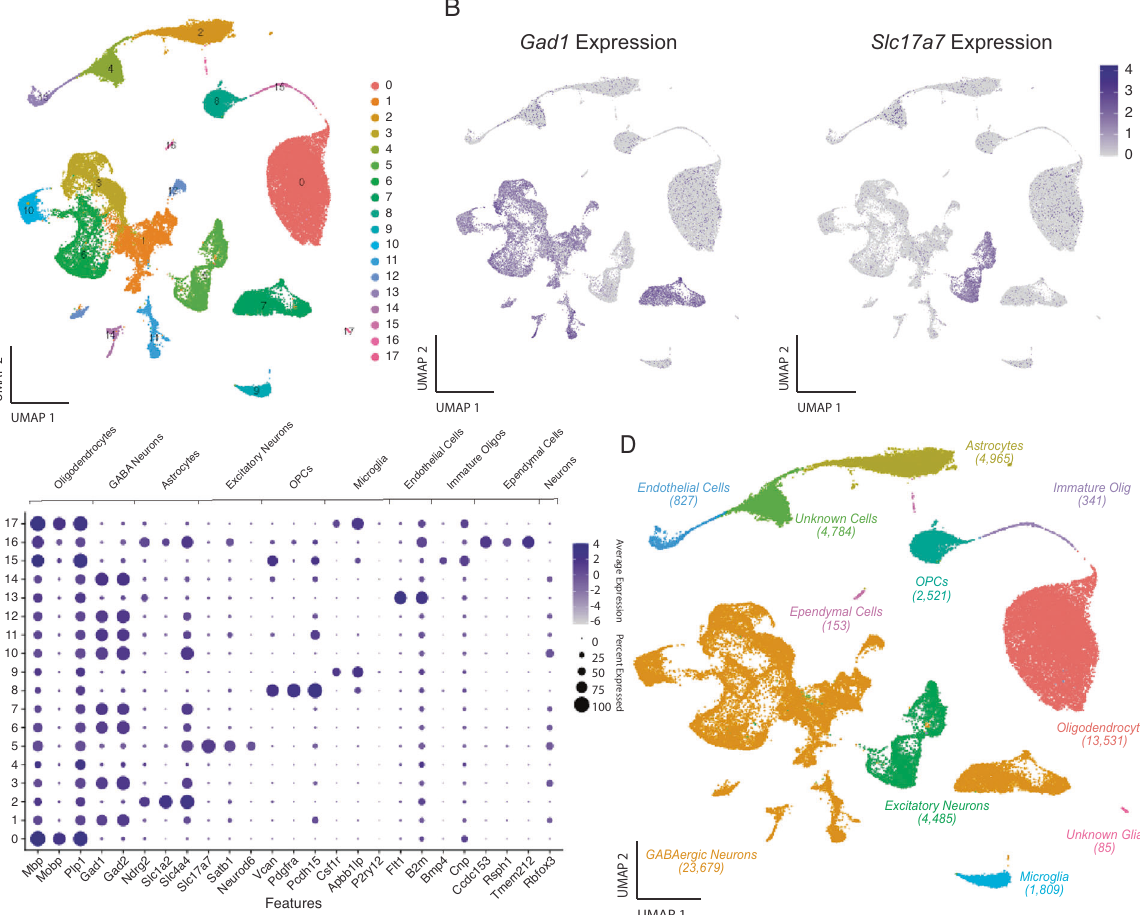
Fig. 1 Identi fi cation of major cell types within the CeA. A UMAP plot of 58,640 CeA single-nuclei colored by cluster. Louvain clustering analysis (resolution = 0.1) identi fi ed 18 transcriptionally de fi ned clusters. B UMAP plots showing the expression levels of select neuronal marker genes. Distinct populations of cells express Gad1 , a marker of GABAergic inhibitory neurons, and Slc17a7 (VGlut2), a marker of glutamatergic excitatory neurons. These data illustrate that one cluster is composed of primarily excitatory neurons, while multiple clusters are identi fi ed which represent distinct inhibitory cell classes of the CeA. C Major cell-type marker gene expression in CeA clusters. The identity of each cluster (0 – 17) was identi fi ed based on the expression of known marker genes for the major cell classes within the CeA. The size of each dot indicates the percentage of cells that contained at least one read of each marker gene; the color depth represents the log-scaled average expression, where the darkest color is the highest expressing cluster. The 24 marker genes that are displayed were identi fi ed based